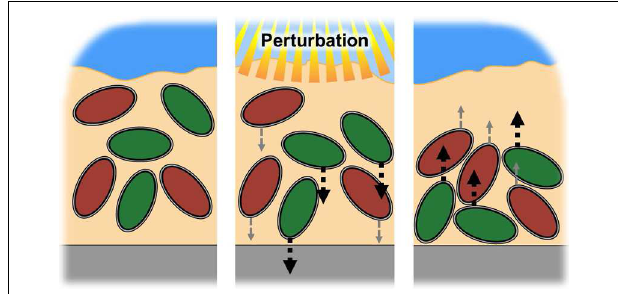
FIGURE 1 | Schematic of model system. A microbial mat has a population of species with differing resilience. In this system, resilience is conferred by movement, with rapid movement (green) having higher resilience than slower movement (red). Both cells respond to a perturbation, in this case light penetration into the mat, by moving out of the zone affected by the perturbation. After the perturbation concludes, the cells recover their initial cell density by moving back into the previously affected region. The faster moving cell has a higher resilience, i.e., the ability to recover population density more quickly, as it is capable of returning more quickly to the previously vacated